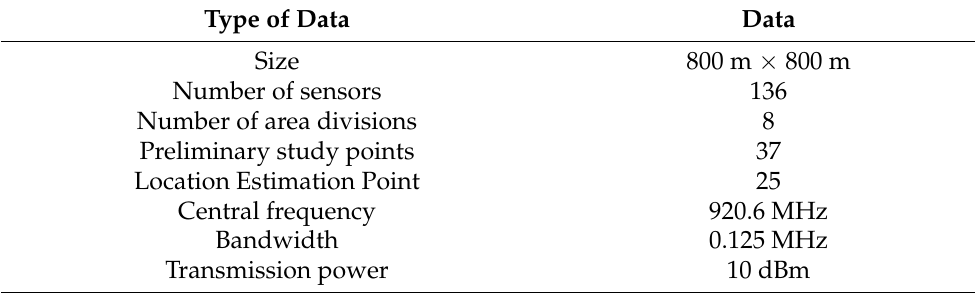
Table 2. simulation parameters